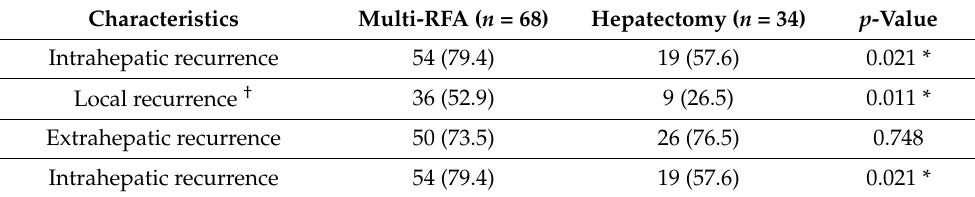
Table 3. Characteristics of recurrence after multi-RFA vs.